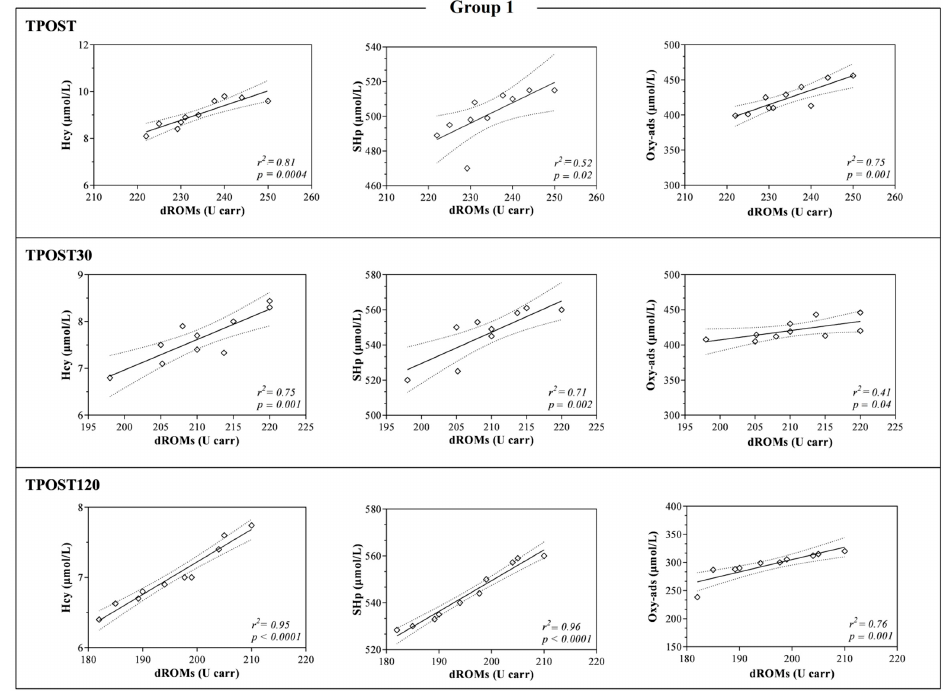
Figure 5. Linear regression values obtained between the serum concentration of reactive oxygen metabolites (dROMs) and the values of homocysteine (Hcy), thiol antioxidant barrier (SHp) and antioxidant barrier (Oxy-ads) obtained immediately after the race (TPOST), and after 30 (TPOST30) and 120 min (TPOST120) in Thoroughbred racehorses competing in 1200 m race (Group 1).